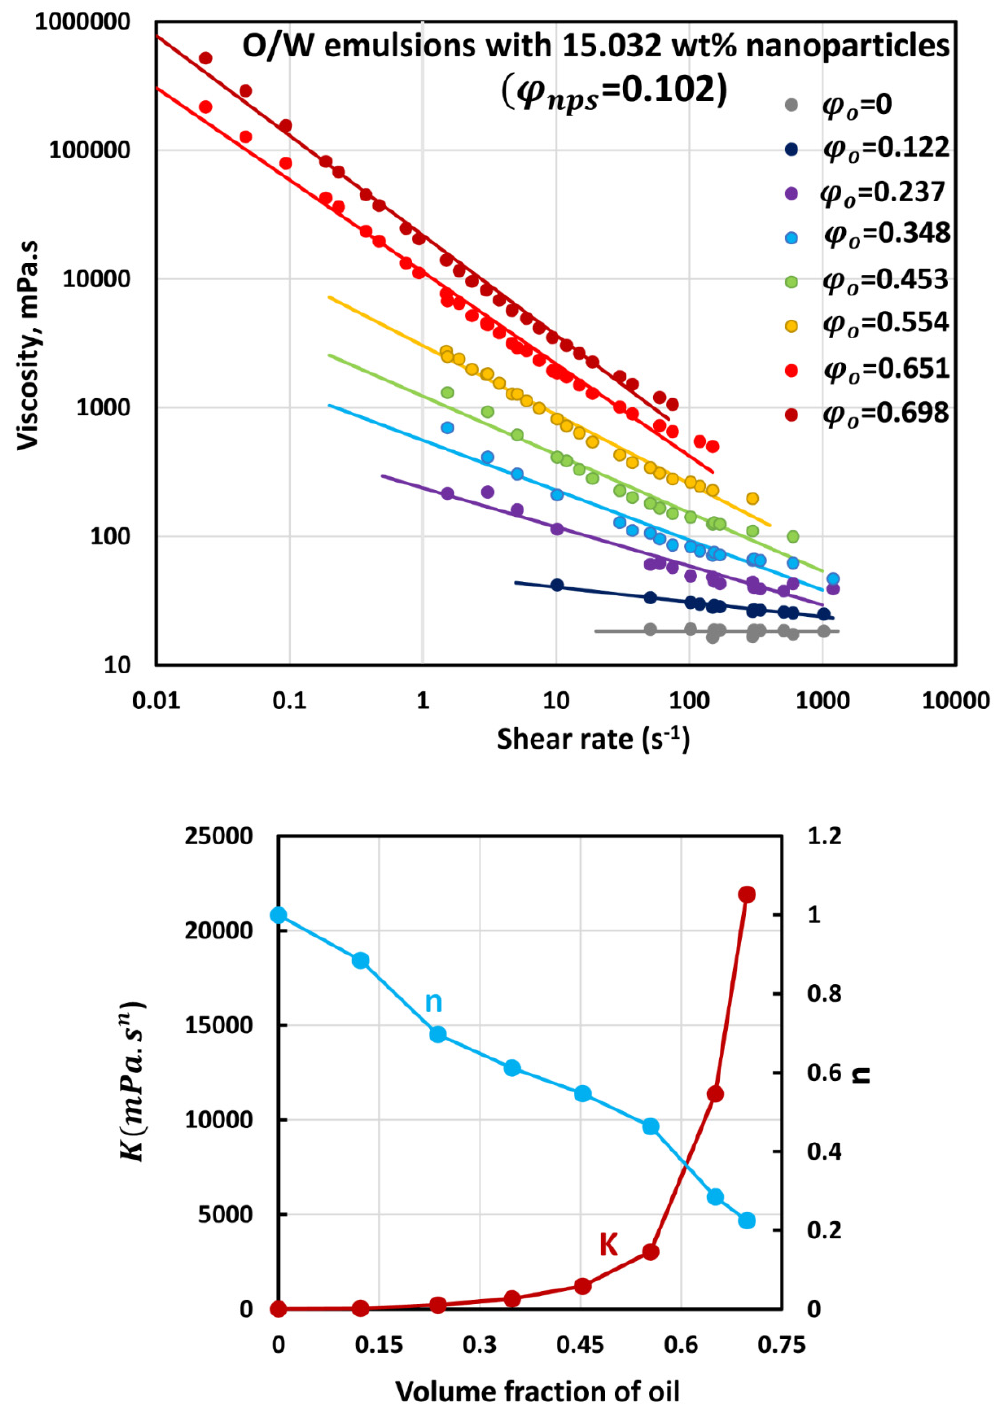
Figure 8. Flow behavior of O/W emulsions thickened with starch nanoparticles at nanoparticle concentration of 15.032 wt% ( ϕ nps = 0.102).